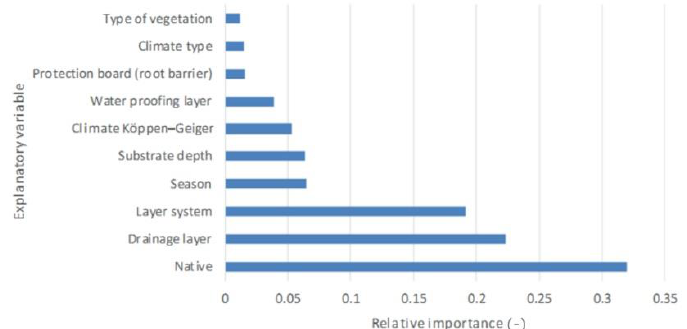
Figure 3. Relative importance of the explanatory variables in the best regression model.